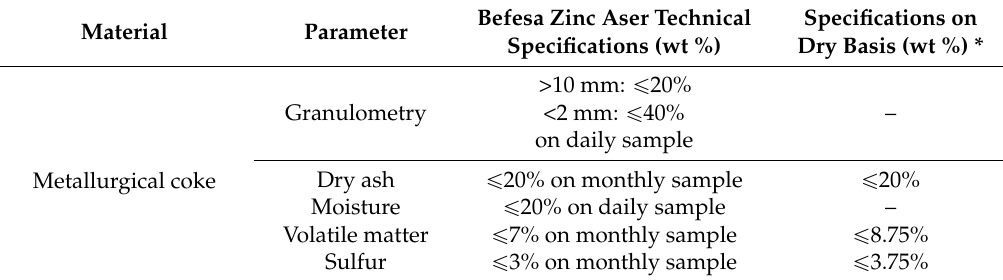
Table 4. Quality specifications for commercial reducing agents required by Befesa Zinc Aser S.A. company